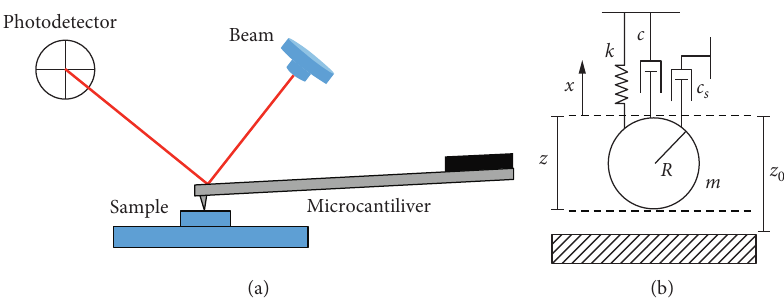
Figure 1: Representation of AFM-TM schematic diagram. (a) Representation of microcantilever beam and (b) representation of analysis tip through a mass-spring-damper